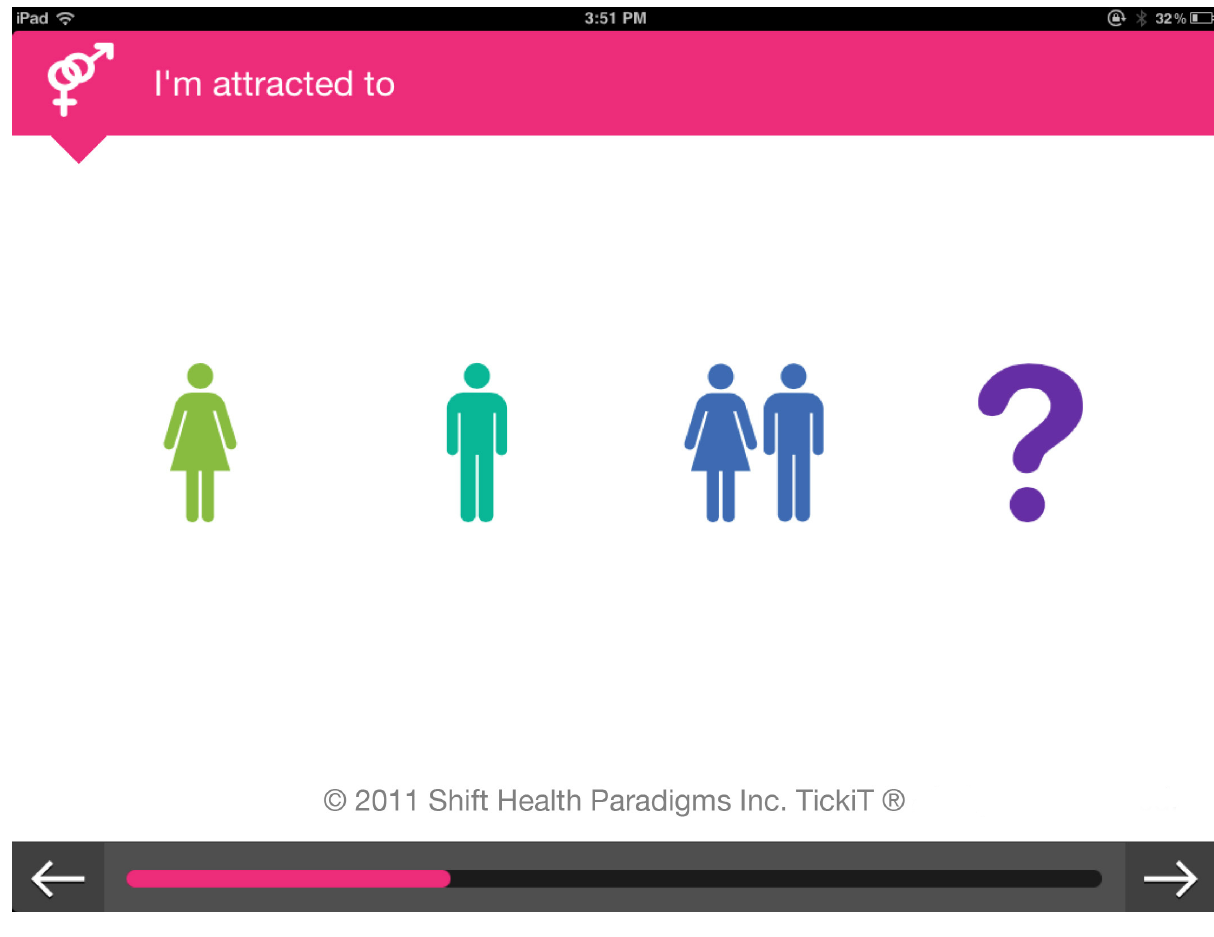
Figure 3. TickiT